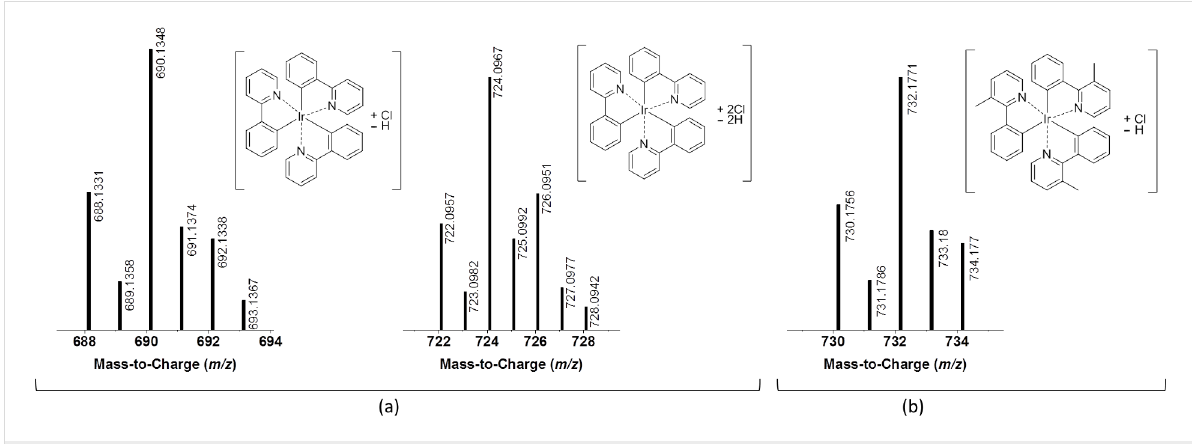
Figure 4: Mass spectra of the identified halogenated degradation products of a) Ir(ppy) 3 after 200 min of irradiation in CH 2 Cl 2 and b) Ir(Me-ppy) 3 after 120 min of irradiation in CH 2 Cl 2 (obtained from the LC–MS analysis of the respective